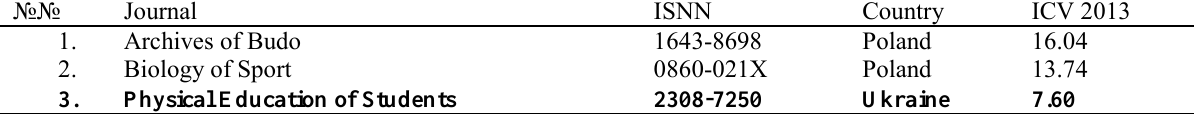
Table 2. Rating of journals in Index Copernicus data base (Sciences about sports; in total 27 journals were indexed; other have no indices) for 2013 by indicator ICV